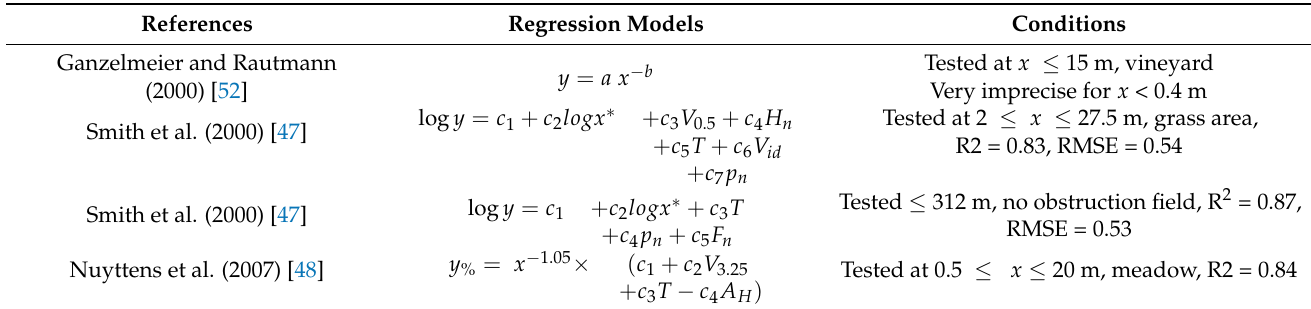
Table 1. Empirical models for spray drift